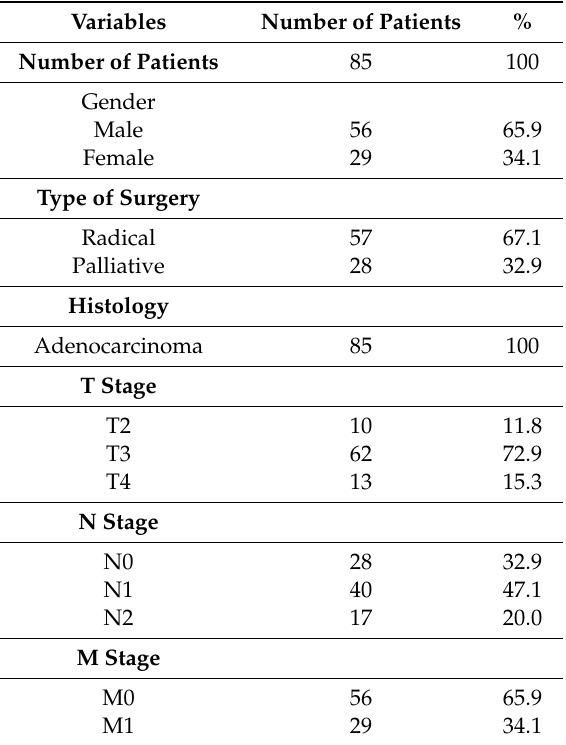
Table 3. Characteristics of patients in the